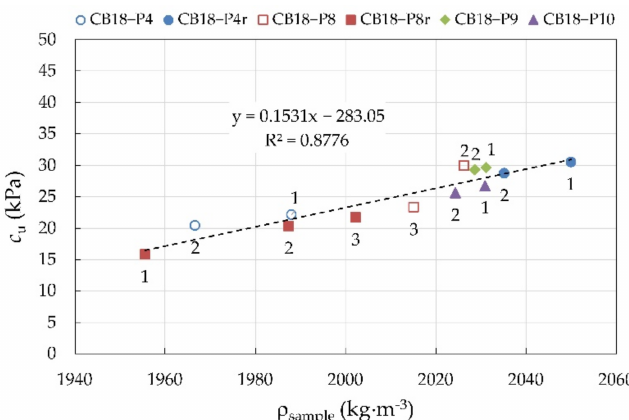
Figure 14. Relation between the compacted soil sample’s density and the unconfined shear strength. Values refer to the number of the